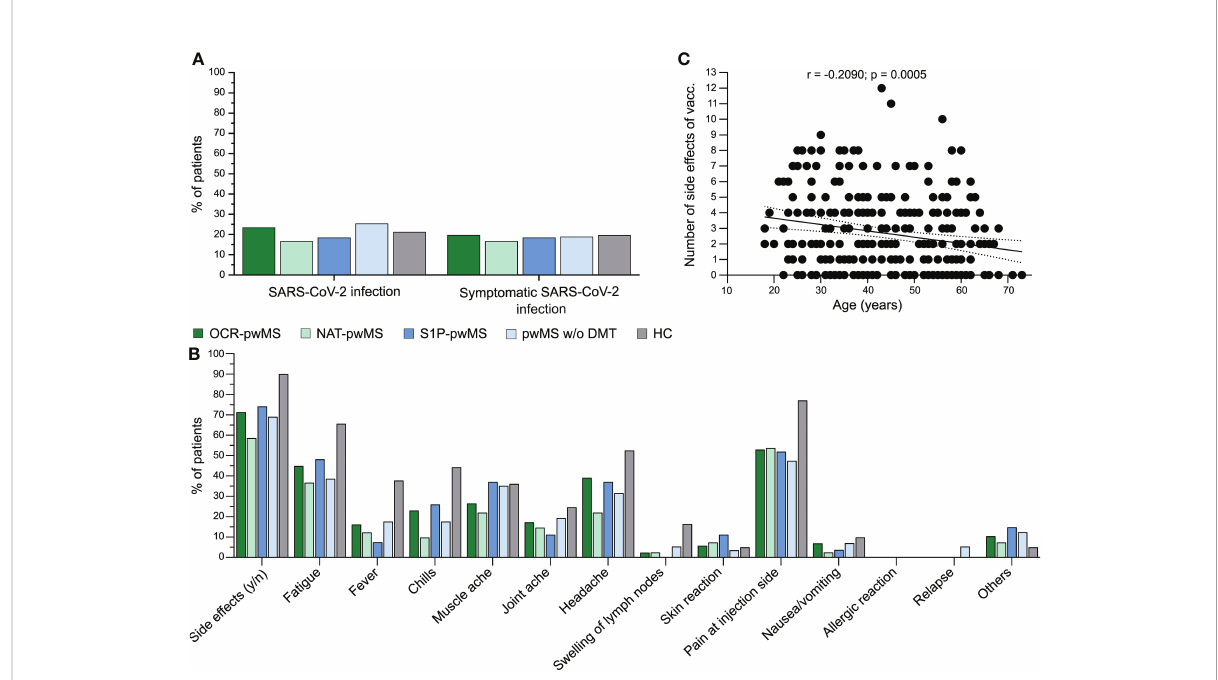
FIGURE 4 Effective vaccine-based clinical protection of MS patients irrespective of treatment regimen and satisfactory safety pro fi le. (A) Comparison of probability of asymptomatic and symptomatic SARS-CoV-2 infection between OCR-pwMS, NAT-pwMS, S1P-pwMS, pwMS w/o DMT, and HC; (B) Comparison of side effects between OCR-pwMS, NAT-pwMS, S1P-pwMS, pwMS w/o DMT, and HC; (C) Correlation of number of side effects with age. Correlation analysis was performed with the Spearman correlation coef fi cient. The area in-between the dotted lines shows the 95% con fi dence interval. OCR, ocrelizumab; HC, controls without MS; MS, multiple sclerosis; n, no; NAT, natalizumab; SARS-CoV-2, severe acute respiratory syndrome; pwMS, patients with MS; S1P, sphingosine 1-phosphate receptor modulator; vacc., vaccination; w/o, without; y,